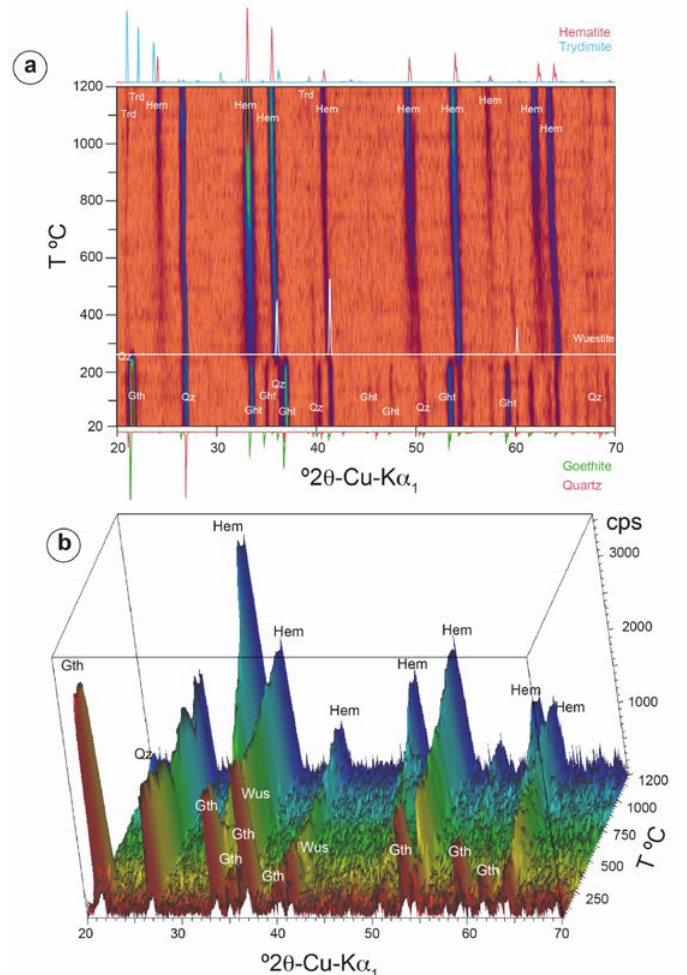
Figure 7. Thermodi ff raction patterns for iron ore from Oiola heated between 30–1205 ◦ C and from 20 to 70 ◦ 2 θ range as stacked patterns showing phase transition at di ff erent temperatures. ( a ) stacking of 1D di ff ractograms; ( b ) stacking of 3D di ff ractograms. Abbreviations after [36]: Hem: Hematite, Qz: Quartz, Trd: Tydimite, Gth-Goethite: Wus: